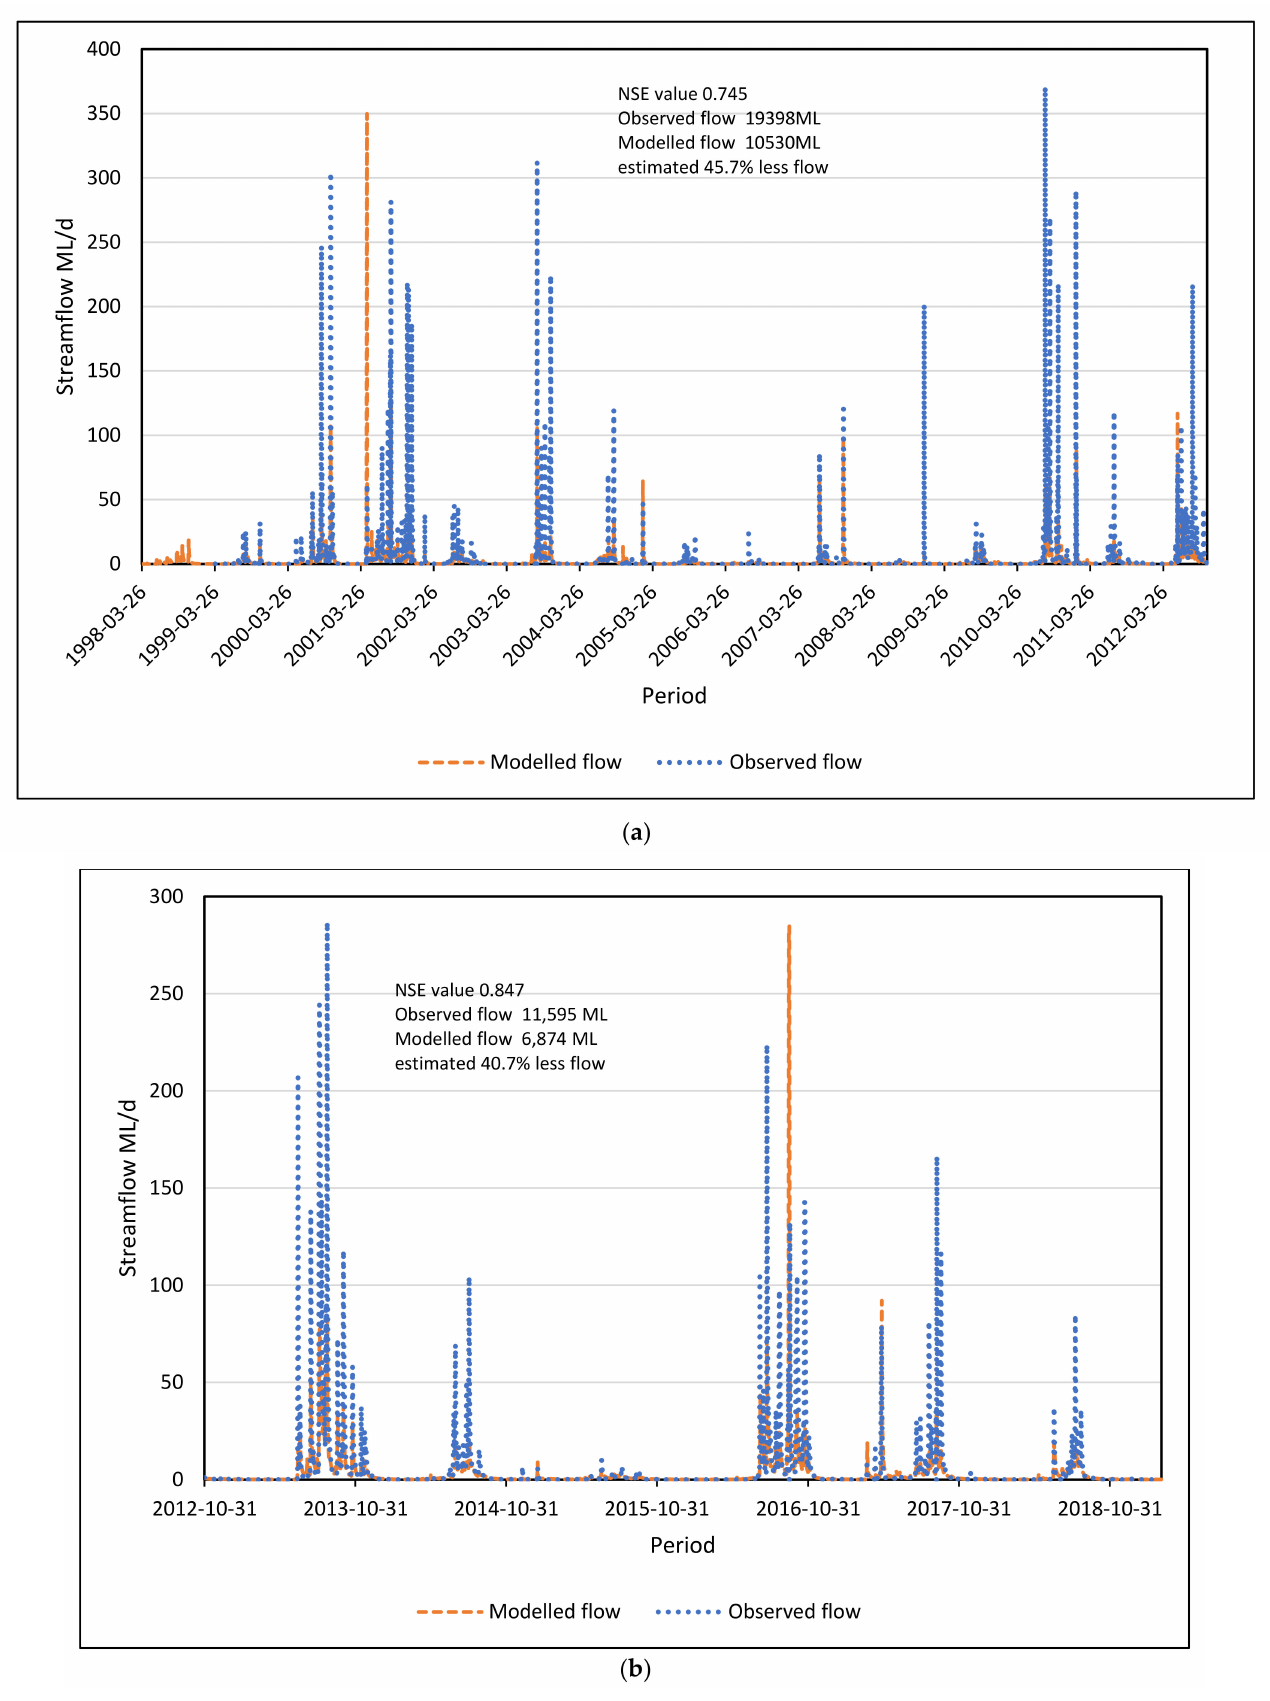
Figure 6. ( a ) GR4J model calibration; ( b ) GR4J model